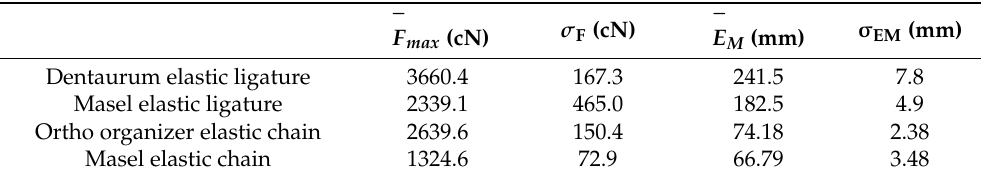
Table 1. The mean values of the maximum force ( F max ), its standard deviation ( σ F ), elongation at F max ; ( E M ), and its standard deviation ( σ EM ).